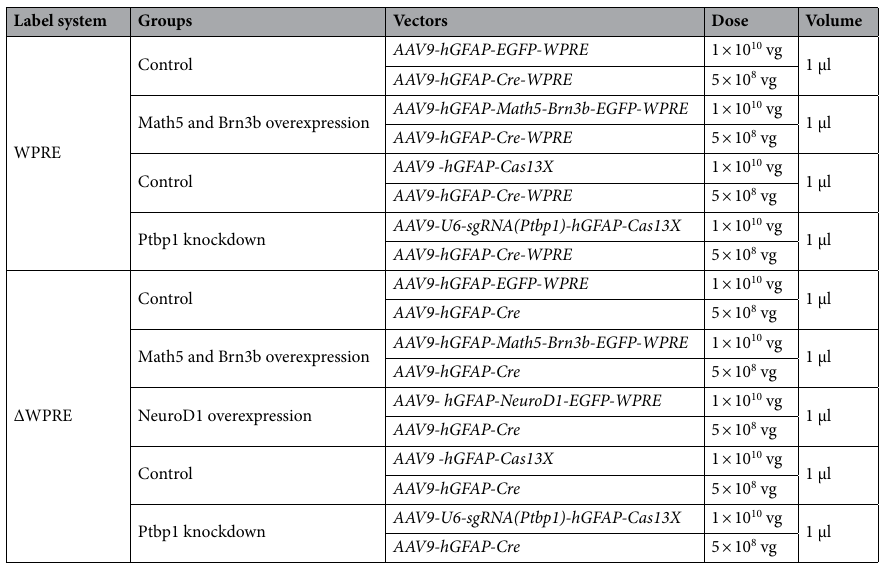
Table 1. Details of subretinal